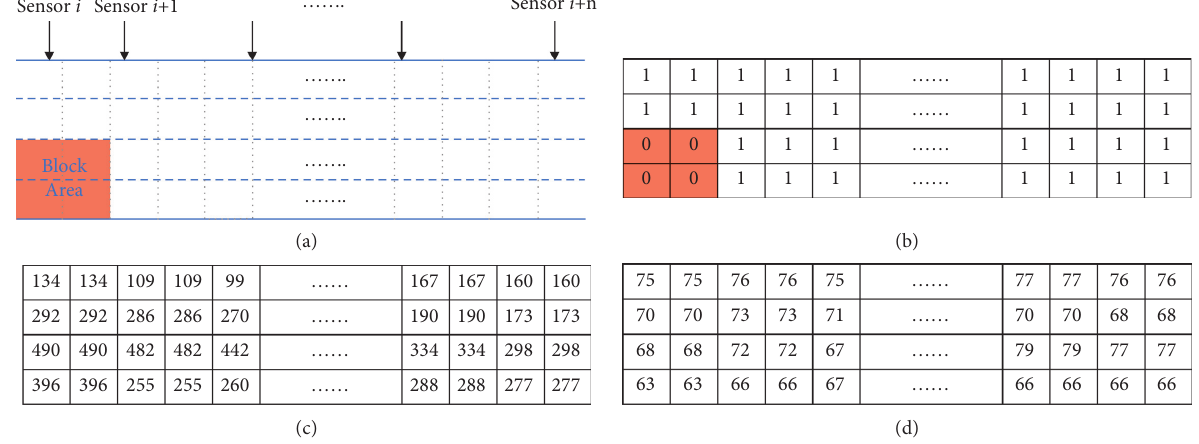
Figure 7: Example of processing traffic environment pictures. (a) Four-lane highway map. (b) Geometry picture. (c) Traffic flow (vehicles/ hour). (d) Average speed (miles/hour).